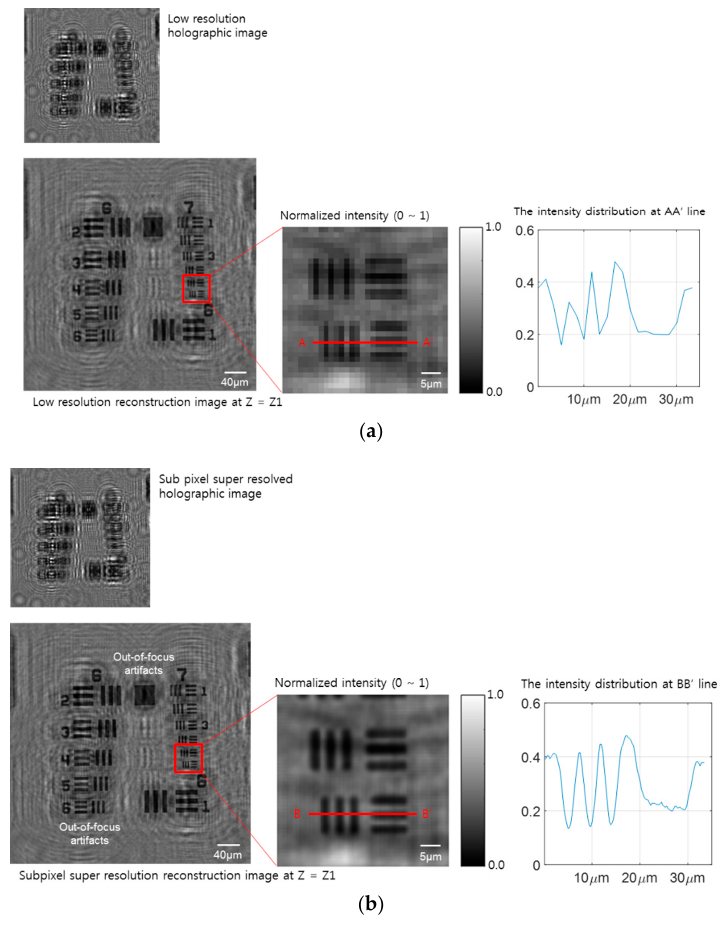
Figure 3. Two image reconstruction results of the USAF object from a set of low-resolution hologram images. ( a ) From the low-resolution hologram in the left upper inset figure, an object image is regenerated with a focused distance by an image processing algorithm, i.e., the angular spectrum method based on Fourier optics. Intensity distribution following the X -axis cutting line is normalized to its maximum value. The minimum resolution is a 2 um FWHM in the USAF target group 1. ( b ) A sub-pixel super-resolution image from the low-resolution set of 36 images. The reconstructed image shows out-of-focus artifacts and a twin image artifact. However, the resolution enhancement is five times greater without the phase recovery step. The line, AA’ and BB’, graph shows a higher contrast, compared with the low-resolution case, and a 6X ideal resolution enhancement.